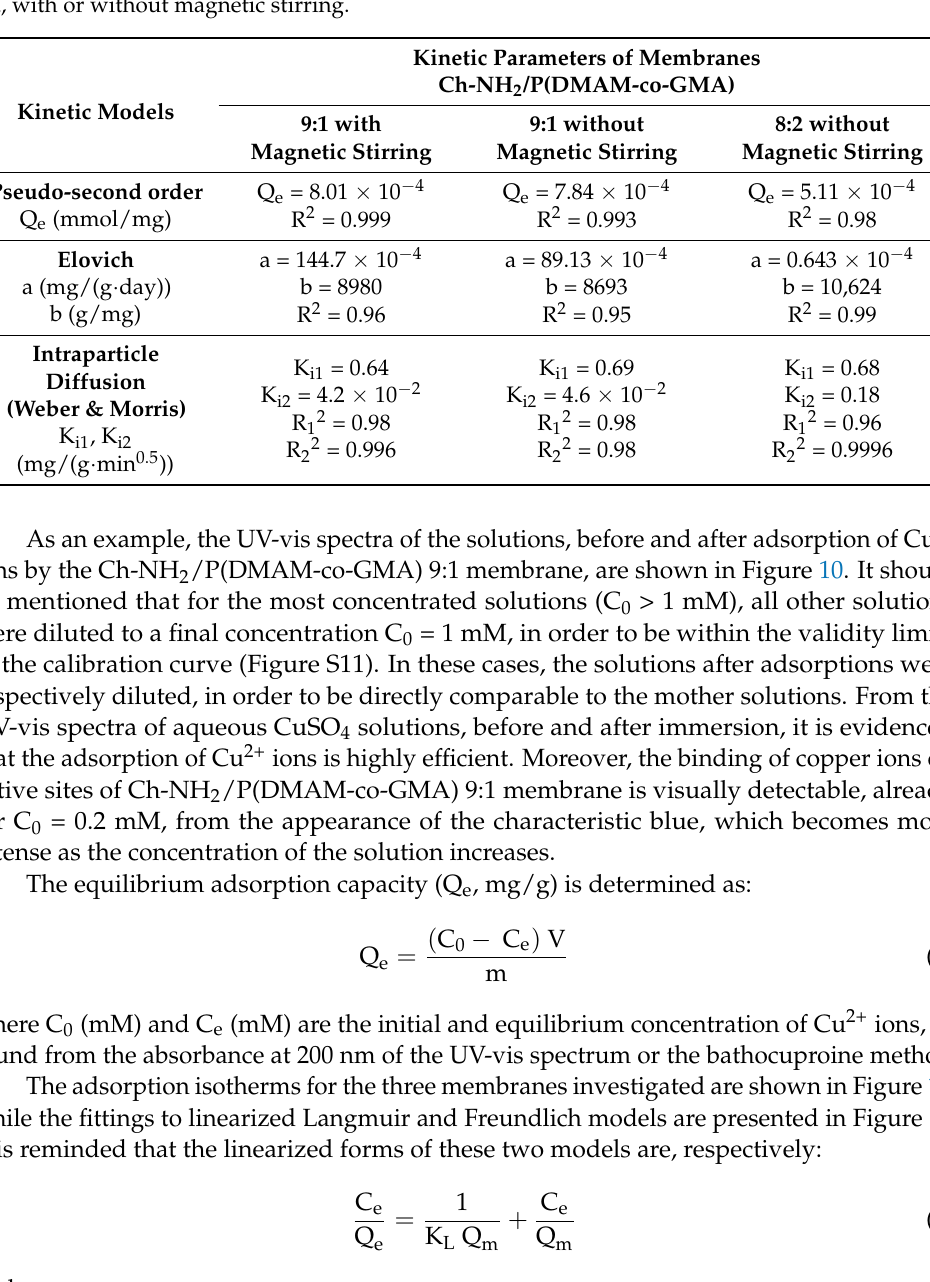
Table 1. Kinetic parameters for pseudo-second order, Elovich and intraparticle diffusion